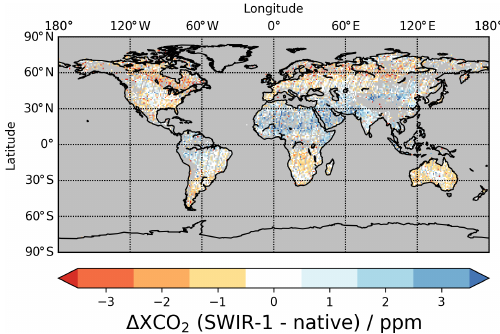
Figure 9. Differences between native GOSAT and SWIR-1 re- trievals averaged on 1 ◦ × 1 ◦ for 8 years of GOSAT observations. The global mean bias over land of 0.45ppm was subtracted from the graph.